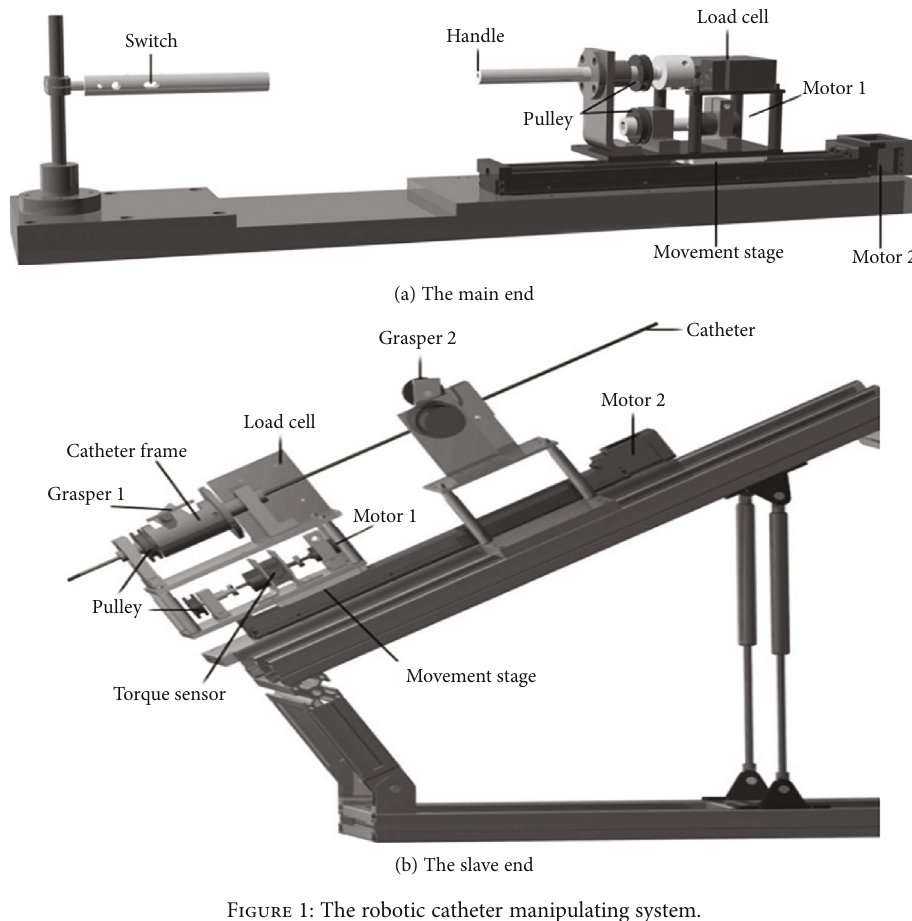
Figure 1: The robotic catheter manipulating system.